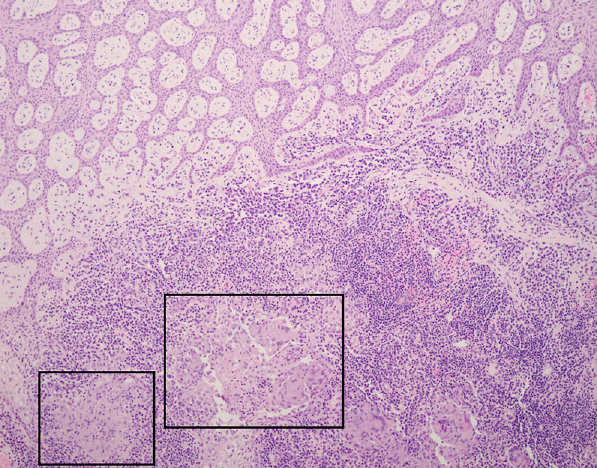
Fig. 4. Histological section of gingiva. Granulomata can be appreciated against a brisk lymphoplasmacytic in fi ltrate; hematox- ylin-eosin, 100 (cid:1)